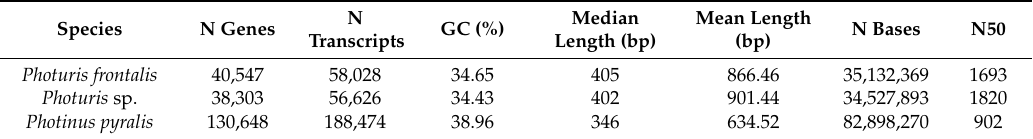
Table 1. Assembly statistics for three firefly species. Statistics compiled from Trinity assembly assessment output (script name / flags). N genes = number of unique genes in assembly, N transcripts = number of unique transcripts (including isoforms) in assembly. GC (%) = GC content percentage in assembly. Median length (bp) = median length of longest isoforms per gene. Mean length (bp) = mean length of longest isoforms per gene. N bases = number of total bases in assembly based on longest isoforms per gene only. N50 = N50 statistic based on longest isoforms per gene only. Assembly statistics for all transcripts, not just longest isoforms, are given in (Supplemental Table S2).